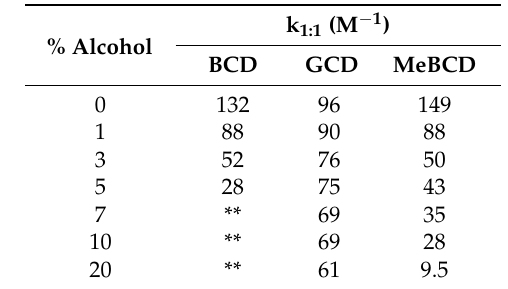
Table 2. Complex formation constants of Prx–CDs in the ternary